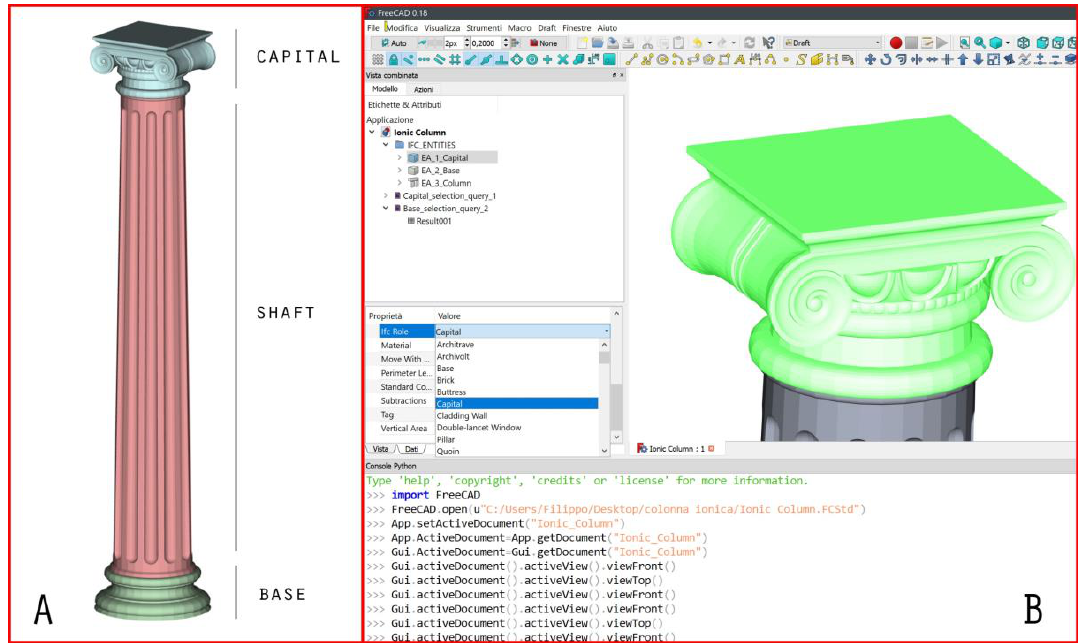
Figure 4. Example of ionic column. ( A ) Ionic column subdivisions: capital in blue; column shaft in red; base in green. ( B ) FreeCAD experimentation: IFC classification of the ionic capital by using custom roles available on the drop-down menu after the implementation.